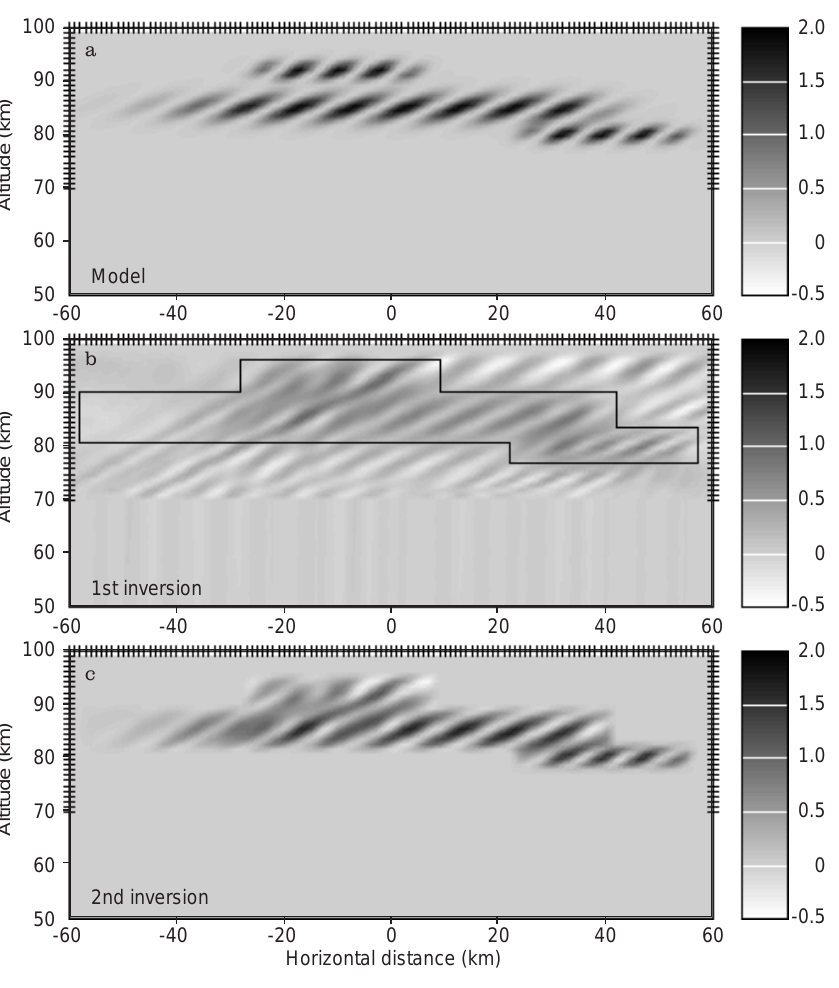
Fig. 7. Same as Fig. 6, with a third wave packet added on the top of the model. The wavelengths and scale height of this wave are the same as those of the second wave packet, but its peak altitude is